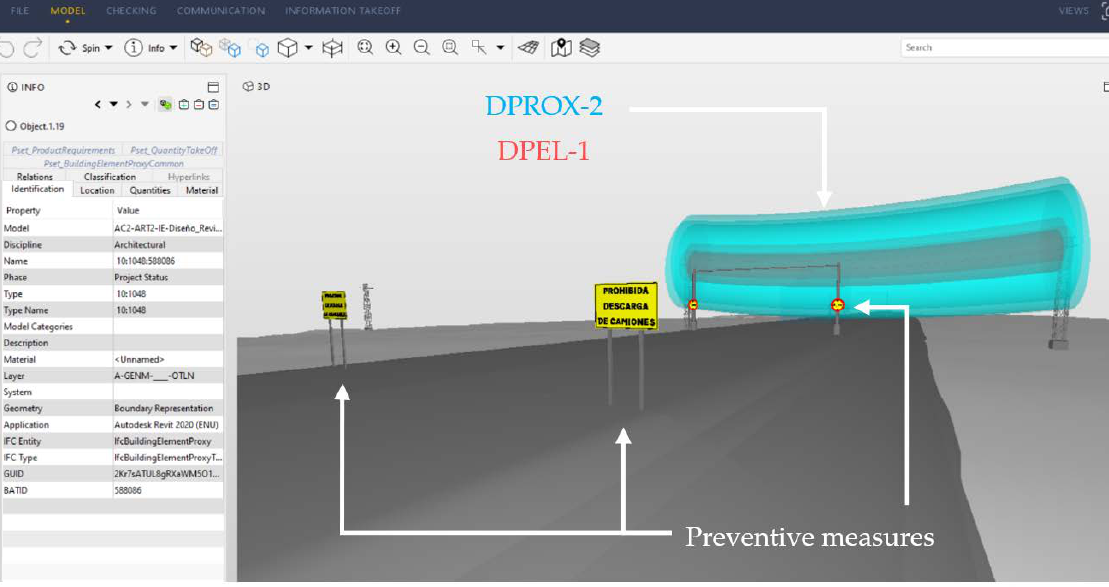
Figure 10. Exporting of preventive measures to IFC for coordination into the project.